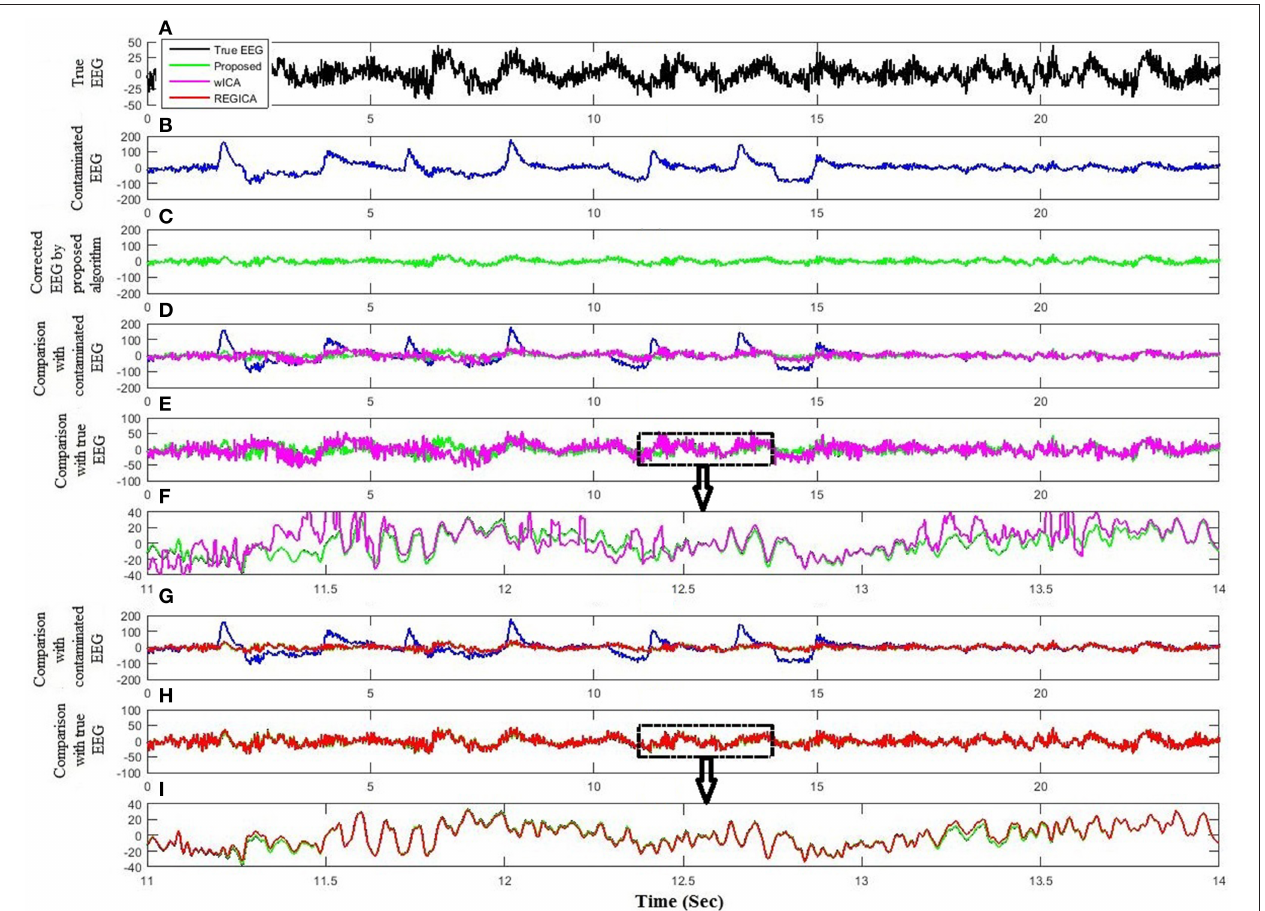
FIGURE 5 | Comparison of the proposed method with wICA and REGICA using simulated dataset. (A) Simulated true EEG data. (B) Artificially contaminated EEG data. (C) Reconstructed EEG by the proposed method. (D) Comparison of the proposed method and wICA reconstructed EEG with artificially contaminated EEG. (E) Comparison of the proposed method and wICA reconstructed EEG with simulated true EEG. (F) Partial enlargement of highlighted region. (G) Comparison of the proposed method and REGICA reconstructed EEG with artificially contaminated EEG. (H) Comparison of the proposed method and REGICA reconstructed EEG with simulated true EEG. (I) Partial enlargement of highlighted